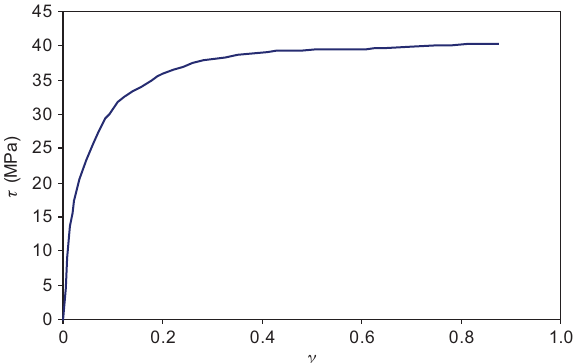
Figure 7 τ – γ diagram of the FM-73 adhesive.